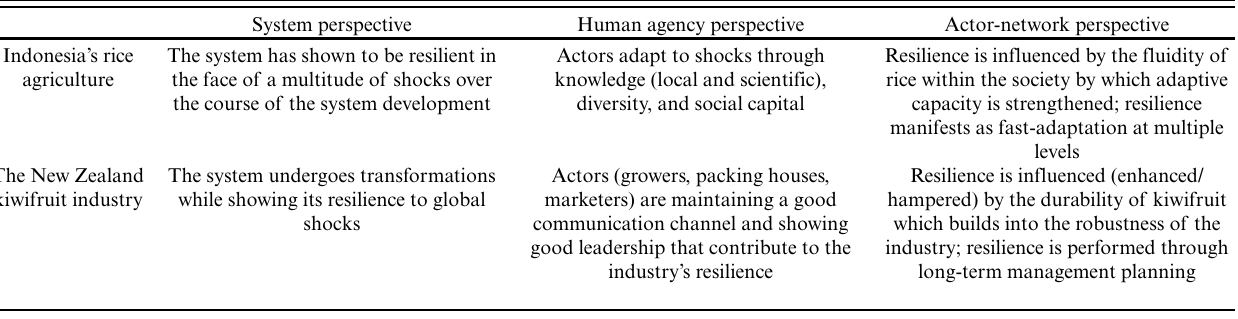
Table 2 . Values of different perspectives in assessing the resilience of the two case